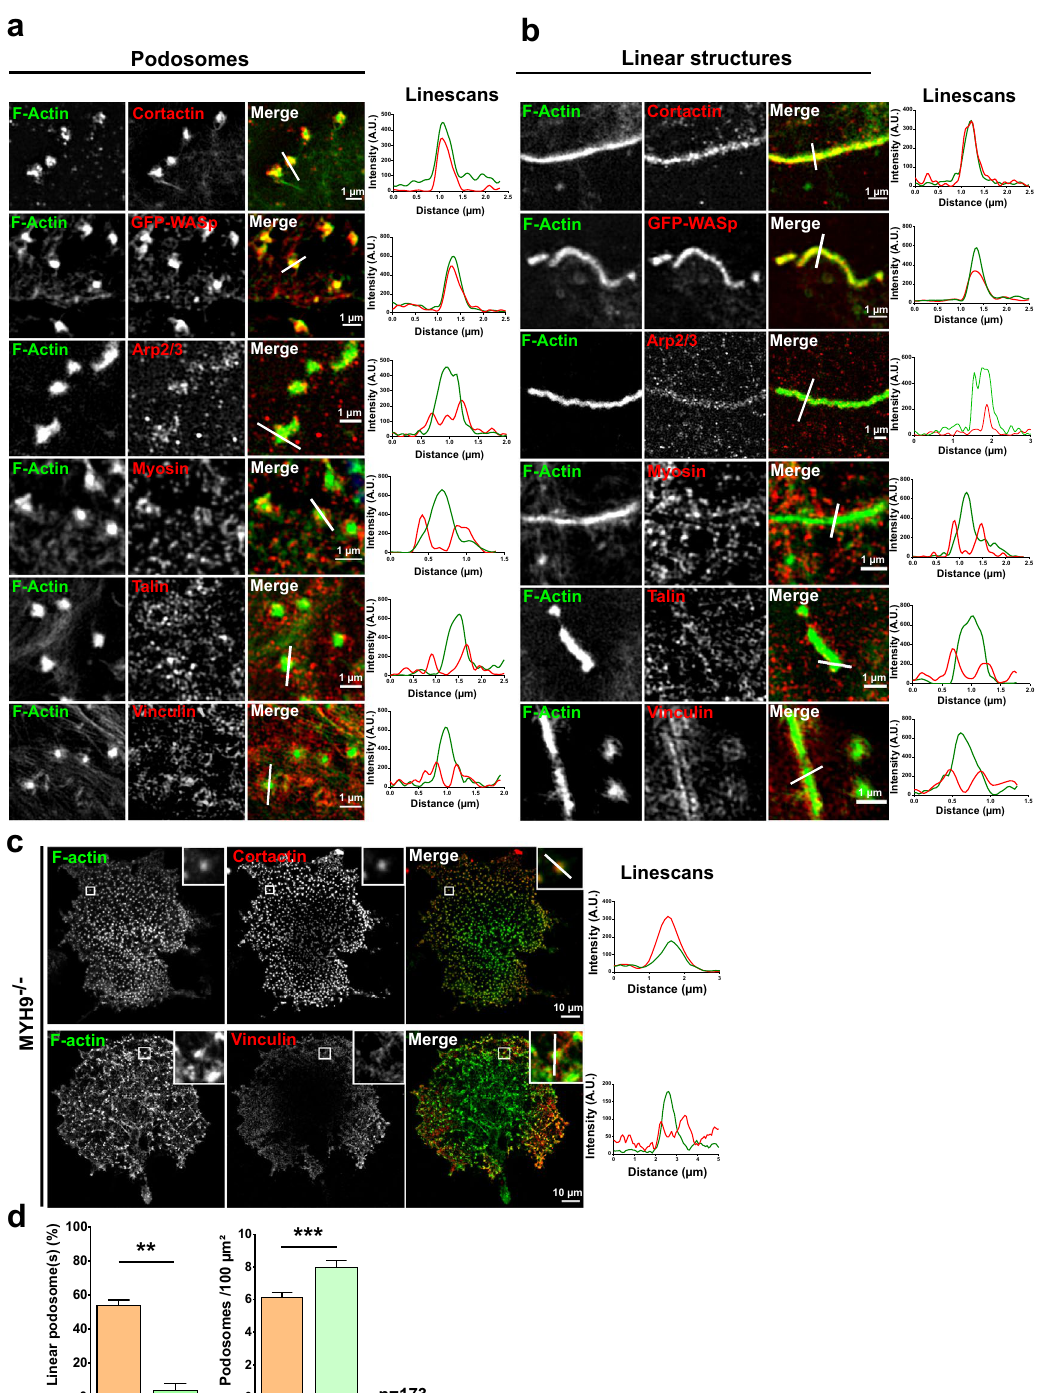
Figure 2. Classical podosomes and collagen-associated F-actin structures share the same protein composition. D3MKs were cultured on 100 µg/ml Horm collagen for 5 h then fixed and permeabilized before staining for F-actin (green) and labeled for cortactin, Arp2/3, myosin IIA, talin and vinculin (red). GFP-WASp was transduced using lentivirus in P and cultured with 50 ng/ml mTPO for 3 days before being processed. Images were taken using SIM. ( a ) Images correspond to dot podosomes ( b ) and linear F-actin structures. Linescans show the distribution of fluorescence along the white line. Scale bars = 1 µm. ( c ) MYH9 −/− D3MKs were treated as above before staining for F-actin, cortactin or vinculin. Scale bars = 10 µm. ( d ) Quantification of percentage of WT and MYH9 −/− MKs forming linear podosomes and of dot-like podosomes (podosomes) density (for 100 µm 2 ). Values (mean ± S.E.M.) are from 5 independent experiments. **P < 0.01 and ***P < 0.001 according to the Mann–Whitney test). n = number of cells